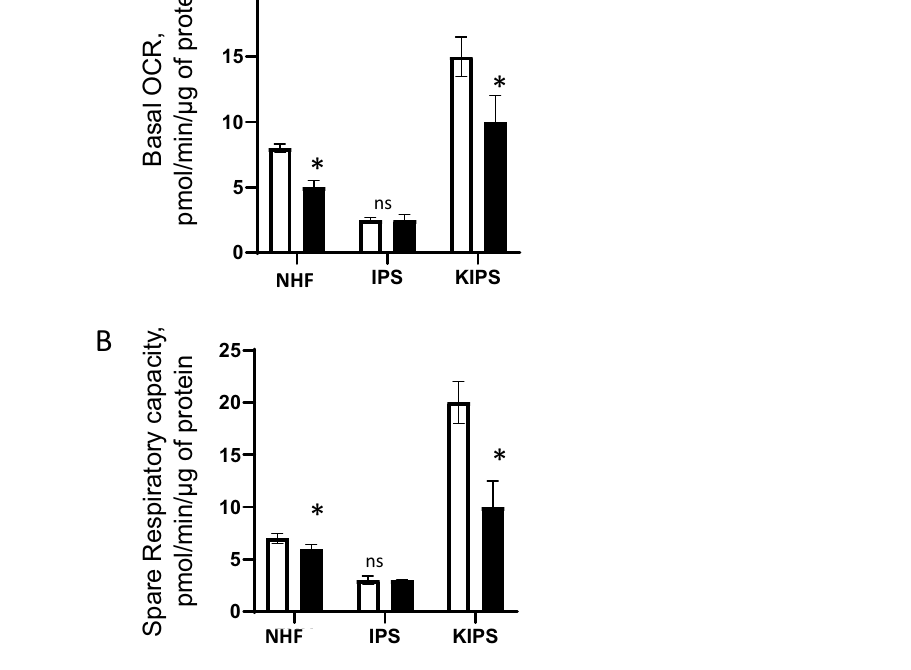
Figure 1. Mitochondrial contribution to the energetic metabolism of fibroblasts and their differentiated counterparts, iPSCs and KiPS. ( A ) The comparison of basal respiration results from Seahorse XF96 analyzer. Fibroblasts (NHF) from a 20-year old (white bars) and a 40-year old donor (black bars) were derived into iPSCs (IPS) and then these cells were differentiated into KiPS (KIPS) (see Materials and Methods). KIPS were analysed at day 8 after their differentiation (n = 2 experiments and 5 replicates). Mitochondrial inhibitors were sequentially injected; and basal respiration, which is the difference between the basal OCR and the oligomycin repressed OCR was determined. ( B ) Spare respiratory capacity is the calculated difference between the FCCP- induced OCR and the basal OCR. Statistical significance was determined by a Student’s t test. ** P < 0.01 and * P < 0.05, errors bars: